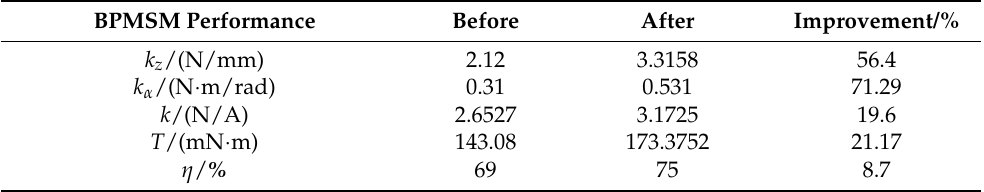
Table 6. Comparison of BPMSM performance, before and after